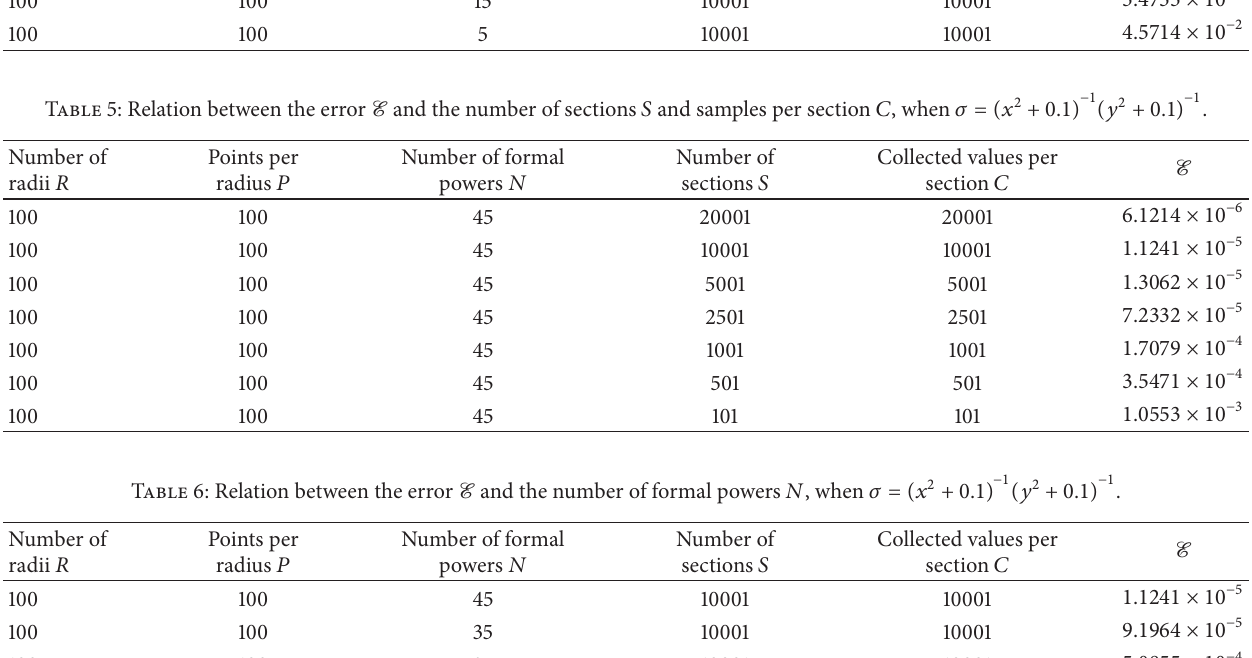
Table 4: Relation between the error E and the number of formal powers 𝑁 , when 𝜎 = 𝑒 𝑥+𝑦 . Number of radii 𝑅